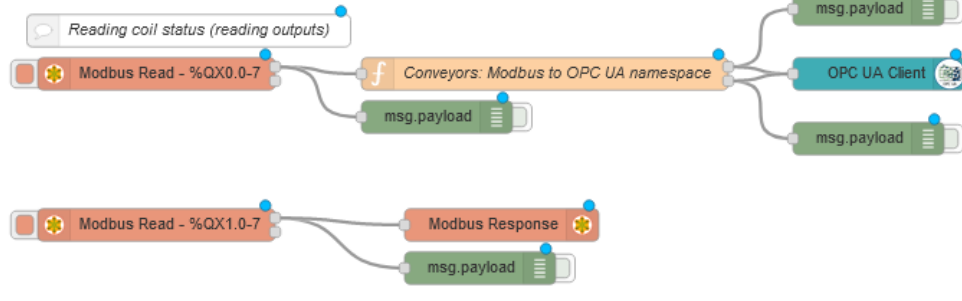
Figure 27. Communication from OpenPLC to Factory I/O.